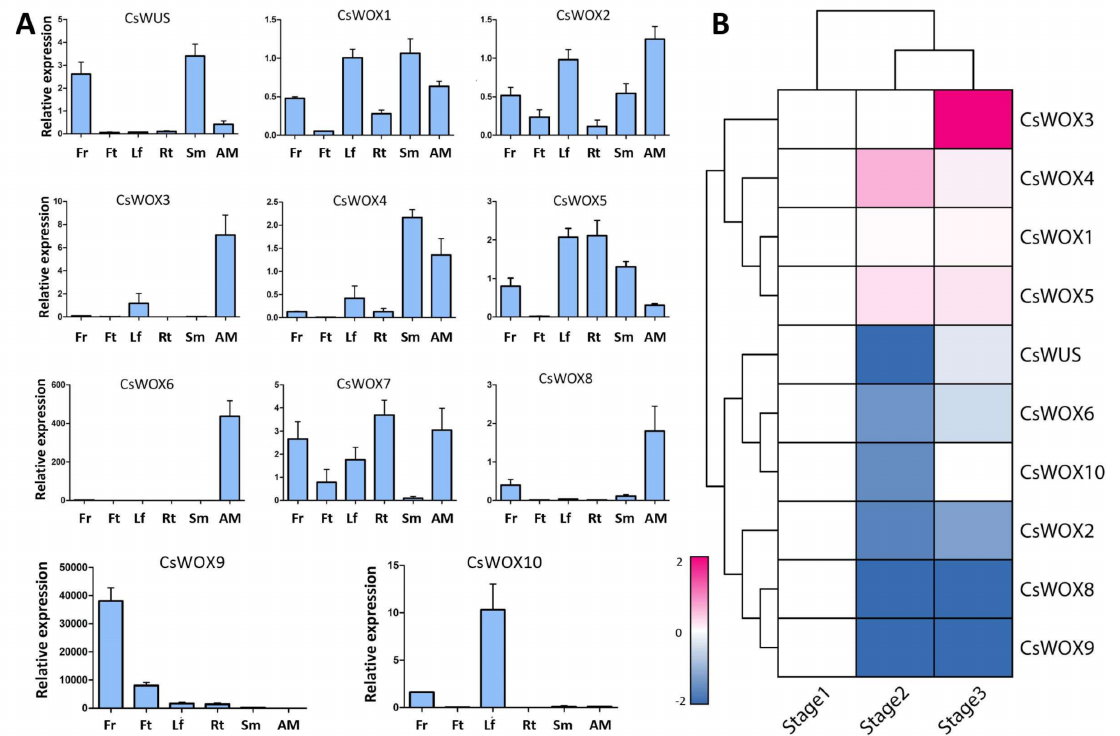
Figure 3. Expression of CsWOX genes in different Citrus sinensis tissues and under floral inductive water deficit conditions. ( A ) Real-time PCR validation for 11 genes expressed in different tissues: leaf (Lf), flower (Fr), fruit (Ft), stem (Sm), apical meristem (AM), and root (Rt). CsActin was used as internal control; mean ± SD of three biological replicates are presented. ( B ) Cluster analysis of CsWOX s expression based on log 2 ratio ≥ 1. Bar denotes different expression levels and colors indicate relative signal intensities. Stage 1: one week before water deficit; stage 2: one week after beginning of water deficit; stage 3: one week after release of water deficit